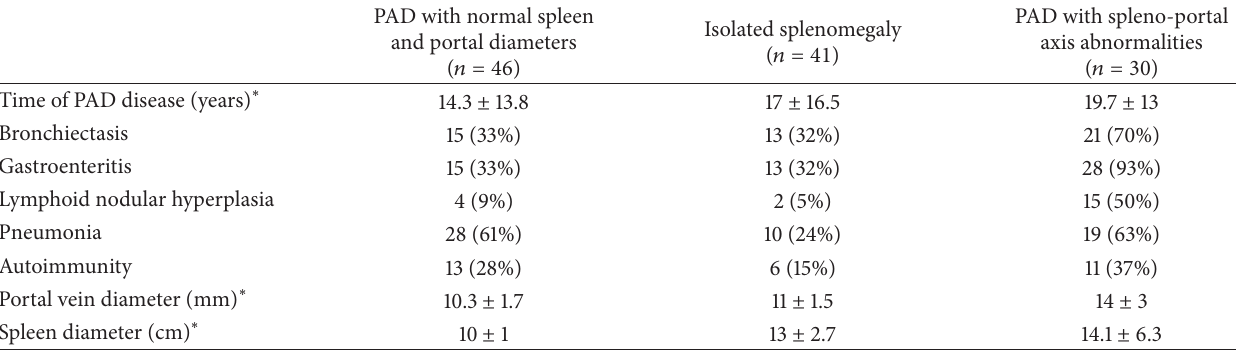
Table 2: Clinical data of 117 PAD patients: without spleno-portal axis abnormalities and with isolated splenomegaly and spleno-portal axis abnormalities.